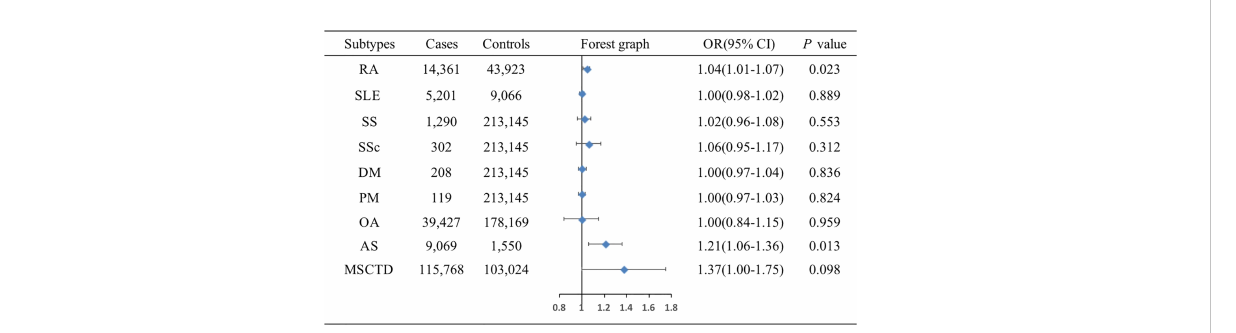
FIGURE 2 Associations of genetic liability to MSCTD with risk of BC in the European individuals. AS, ankylosing spondylitis; BC, breast cancer; DM, dermatomyositis; MSCTD, diseases of the musculoskeletal system and connective tissue; OA, osteoarthritis; PM, polymyositis; RA, rheumatoid arthritis; SLE, systemic lupus erythematosus; SSc, systemic sclerosis; SS, Sjogren syndrome; CI, con fi dence interval; OR, odds ratio.